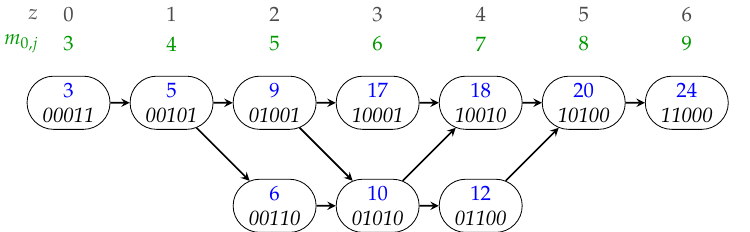
Figure 4. Directed graph of the partially ordered set of candidates j 2 (blue) with corresponding binary expansion (black) for P = 5 and x =